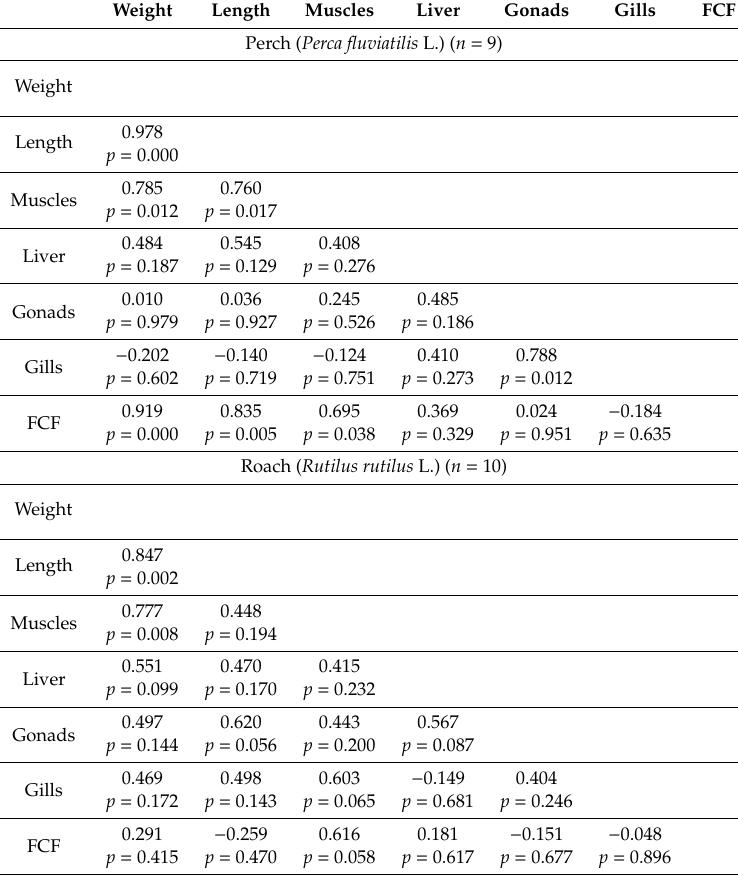
Figure 2. Interspecific differences (Mean ± SD) in the content of mercury in the organs of the same fish species; a, b, c and d, significant difference ( p ≤ 0.05). The same letter indicates the absence of significant differences between organs of the same fish studied. Table 2. Linear correlation coe ffi cients (r) between mercury content in the organs of perch and roach and body weight, total length or Fulton’s condition factor